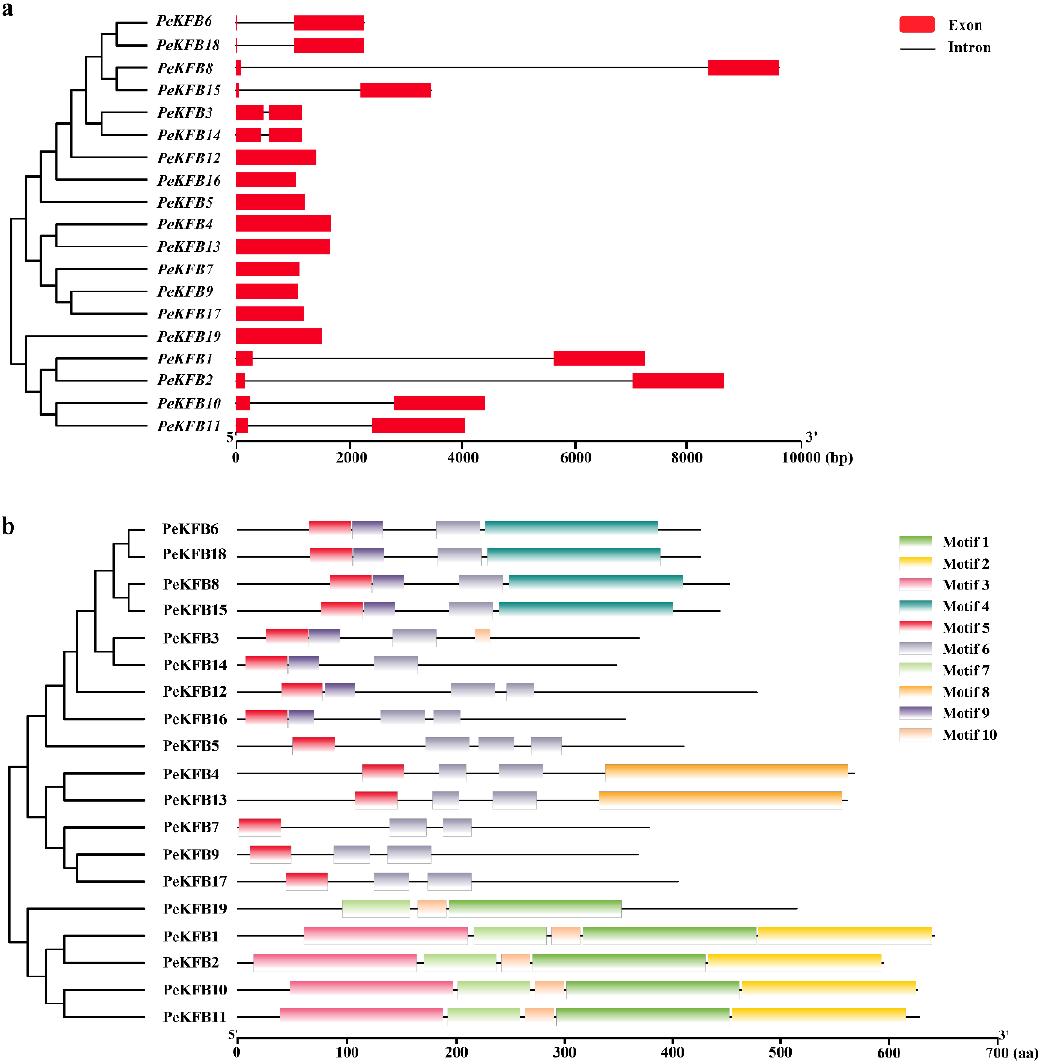
Figure 2. Structural features of KFB family members in moso bamboo. ( a ) Gene structures of PeKFB s. Red boxes: exons; lines between the boxes: introns. The scale bar at bottom demonstrates the length of exons and introns. ( b ) Conserved motifs of PeKFBs. Motifs 1–10 are presented in boxes with different colors. The motif information was obtained from the MEME website and visualized in TBtools.